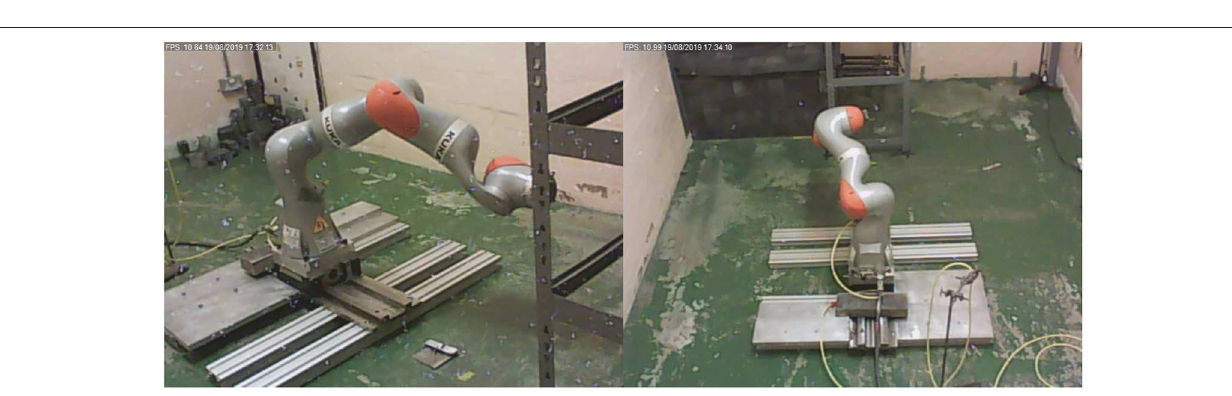
FIGURE 6 | The robotic arm was observed during dynamic irradiation test using two webcams located inside the irradiation cell. Speckle may be observed in both